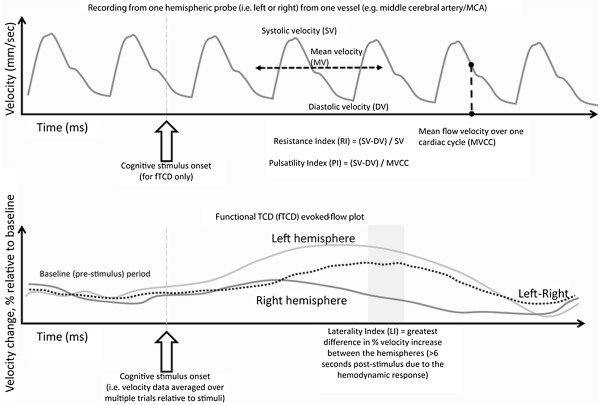
Top: recording from one hemispheric probe in one vessel including calculation of TCD metrics: systolic peak flow velocity, diastolic velocity, mean flow velocity, resistance index and pulsatility index. Bottom: functional TCD (fTCD) evoked-flow plot including calculation of laterality index.